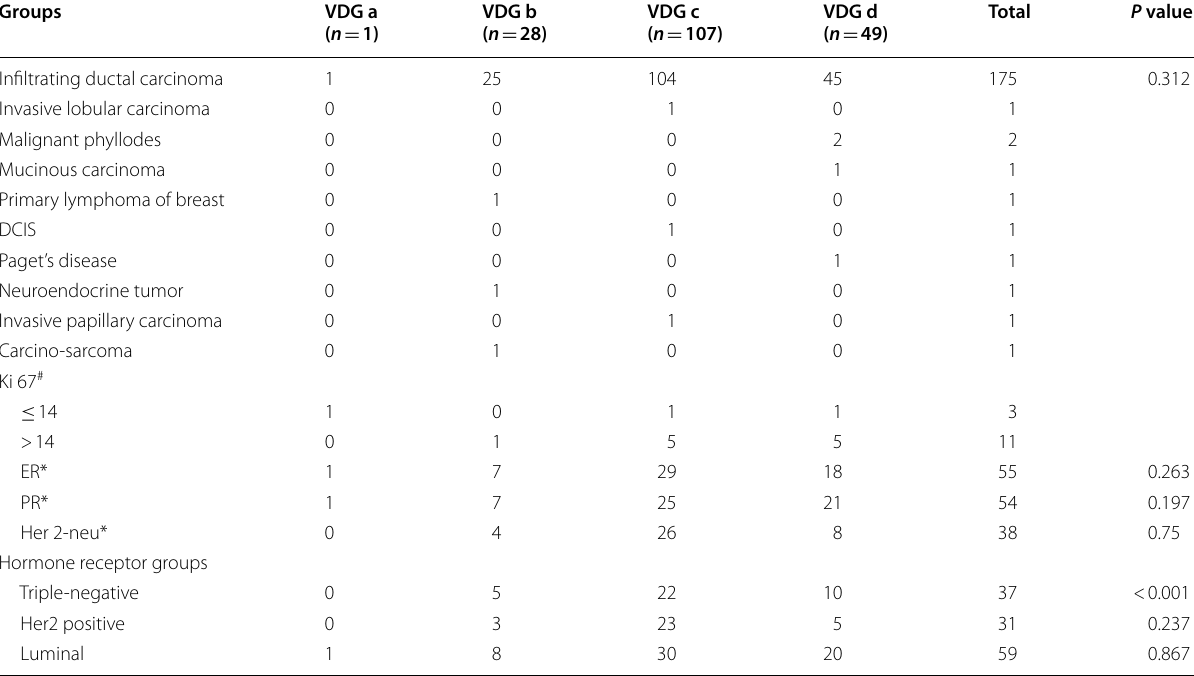
Table 6 Association of different pathological types of breast carcinoma, hormone receptor status and hormone receptor groups in different density